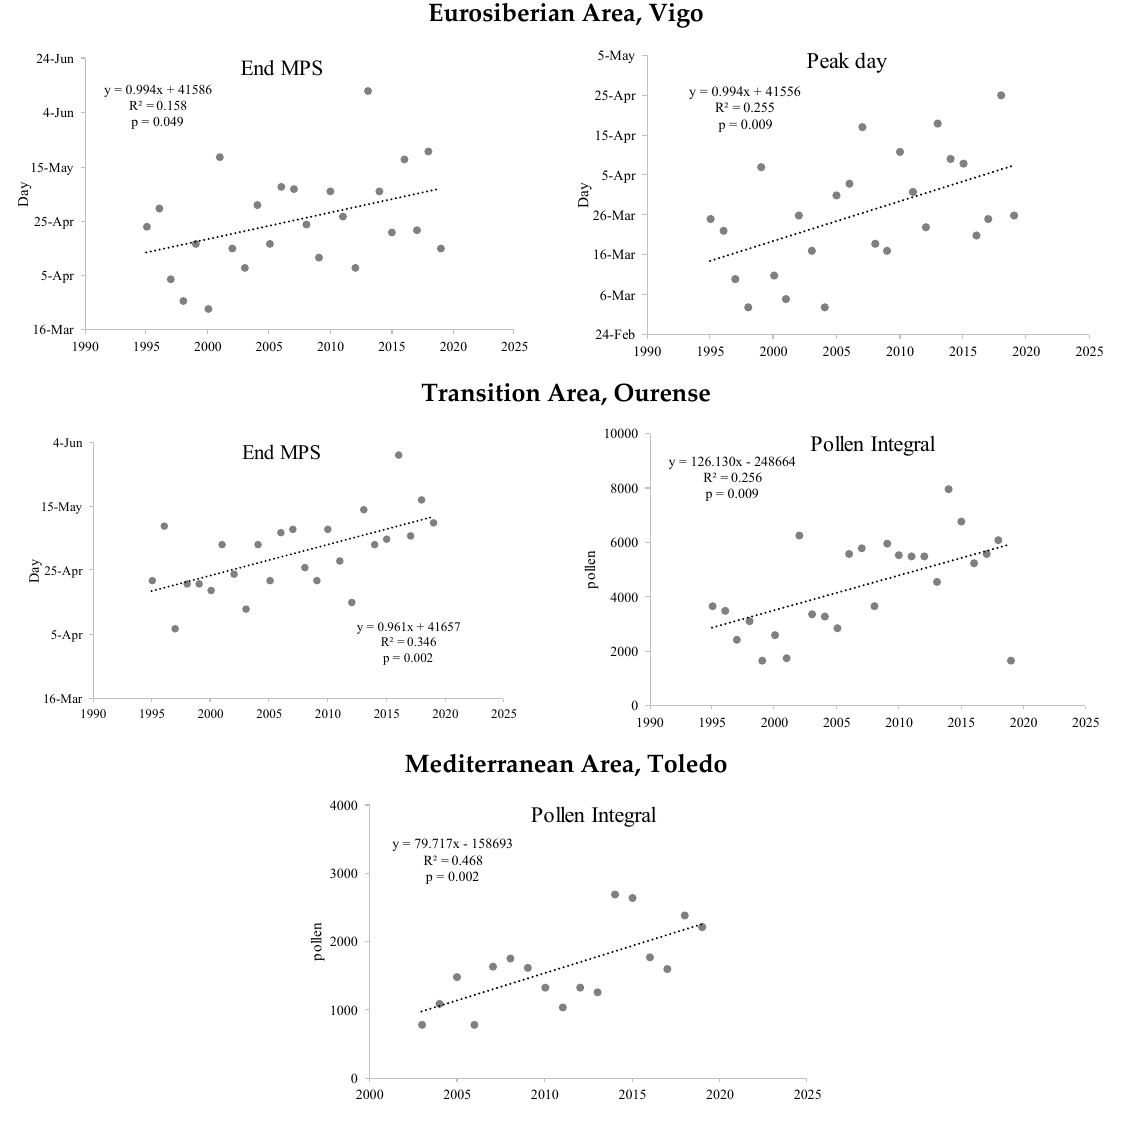
Figure 4. Significant trends of the airborne Pinus main pollen season (MPS) during the entire study period in each study area.